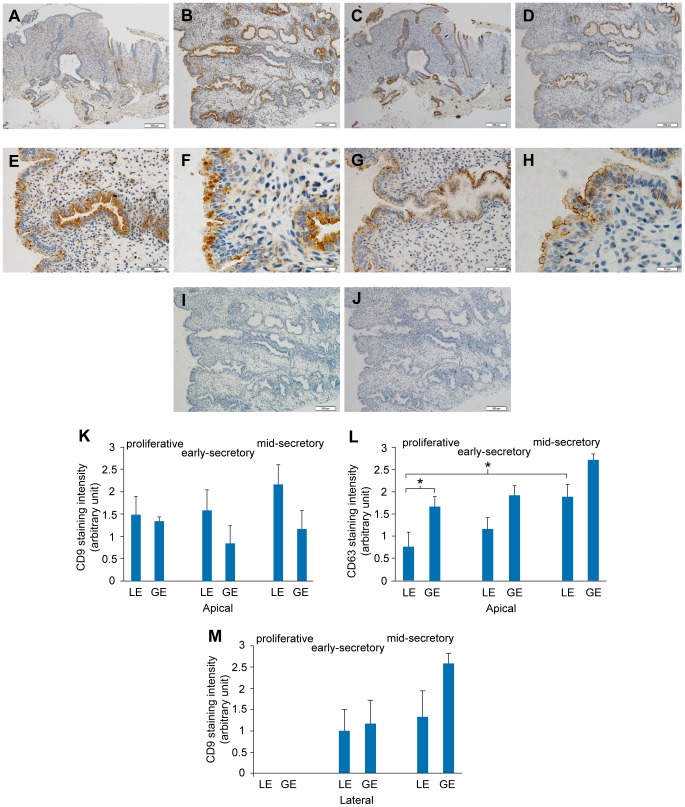
Immunostaining for CD9 and CD63 in endometrium across the menstrual cycle.A–J. Immunostaining for the tetraspanins (CD63. CD9) that were subsequently used as exosomal markers, in endometrial tissues. Endometrial staining for CD63 (plates A,B,E,F) and CD9 (plates C,D,G,H) across the menstrual cycle. Plates A,C: proliferative phase and plates B,D,E–H: secretory phase respectively. Negative controls (Plates I,J). Size bars represent 200 µm (A–D, I–J), 50 µm (E,G), 20 µm (F, H). K–M. Semiquantitative analysis for CD63 (L) and CD9 (K) in luminal epithelium (LE) and glands (GE) in proliferative, early- and mid-secretory phases. Apical (K) and lateral (M) staining for CD9 are presented separately, while CD63 was detected only as apical stain.